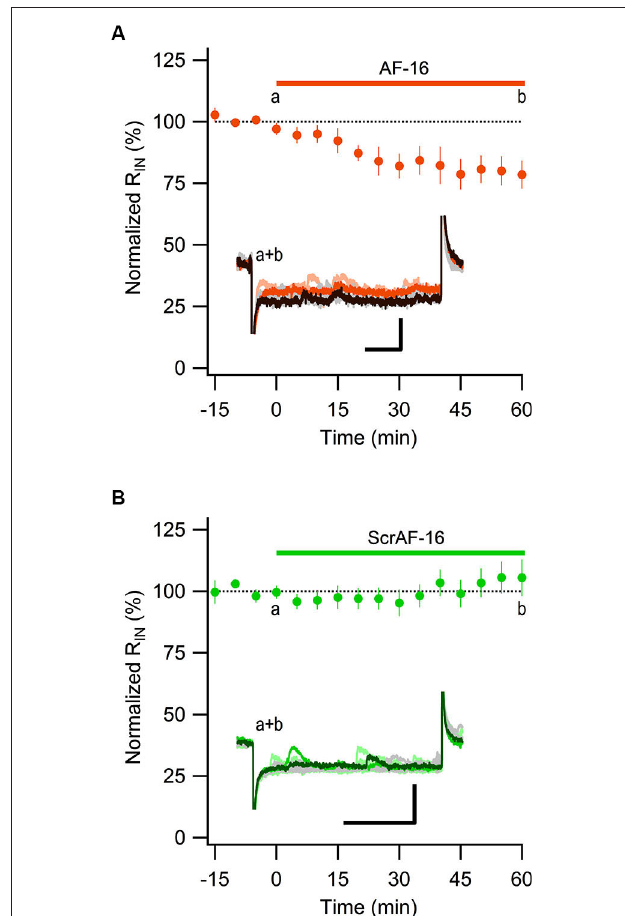
FIGURE 4 | AF-16 reduces the input resistance in CA1 stratum radiatum interneurons. (A) Summary graph of average ( ± s.e.m.) input resistance during application of AF-16 in CA1 stratum radiatum interneurons ( n = 8). Representative traces from time points a (orange/light orange colors) and b (dark brown/gray colors) are shown inside the graph, scale bar represents 30 pA and 75 ms. (B) Summary graph of average ( ± s.e.m.) input resistance during application of scrambled AF-16 in CA1 stratum radiatum interneurons ( n = 8). Representative traces from time points a (green/light green colors) and b (dark green/gray colors) are shown inside the graph , scale bar represents 30 pA and 75